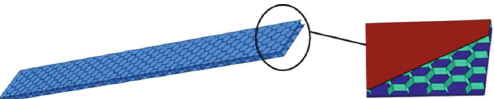
Figure 5: Mesomodel of honeycomb sandwich